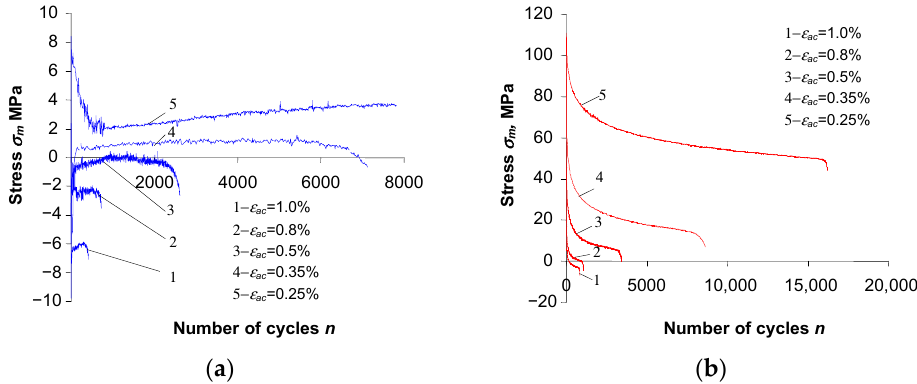
Figure 10. Changes in mean stress 𝜎 𝑚 versus number of cycle: ( a ) as-received specimens, ( b ) pre-strained specimens.